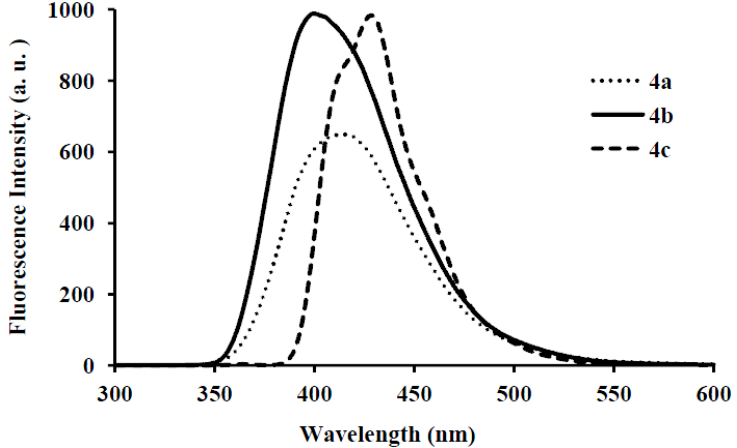
Figure 12. The fluorescence emission spectra of 4a – c ( λ (1:1, v/v) (conc. 2.0 × 10 − 7 mol/L) at